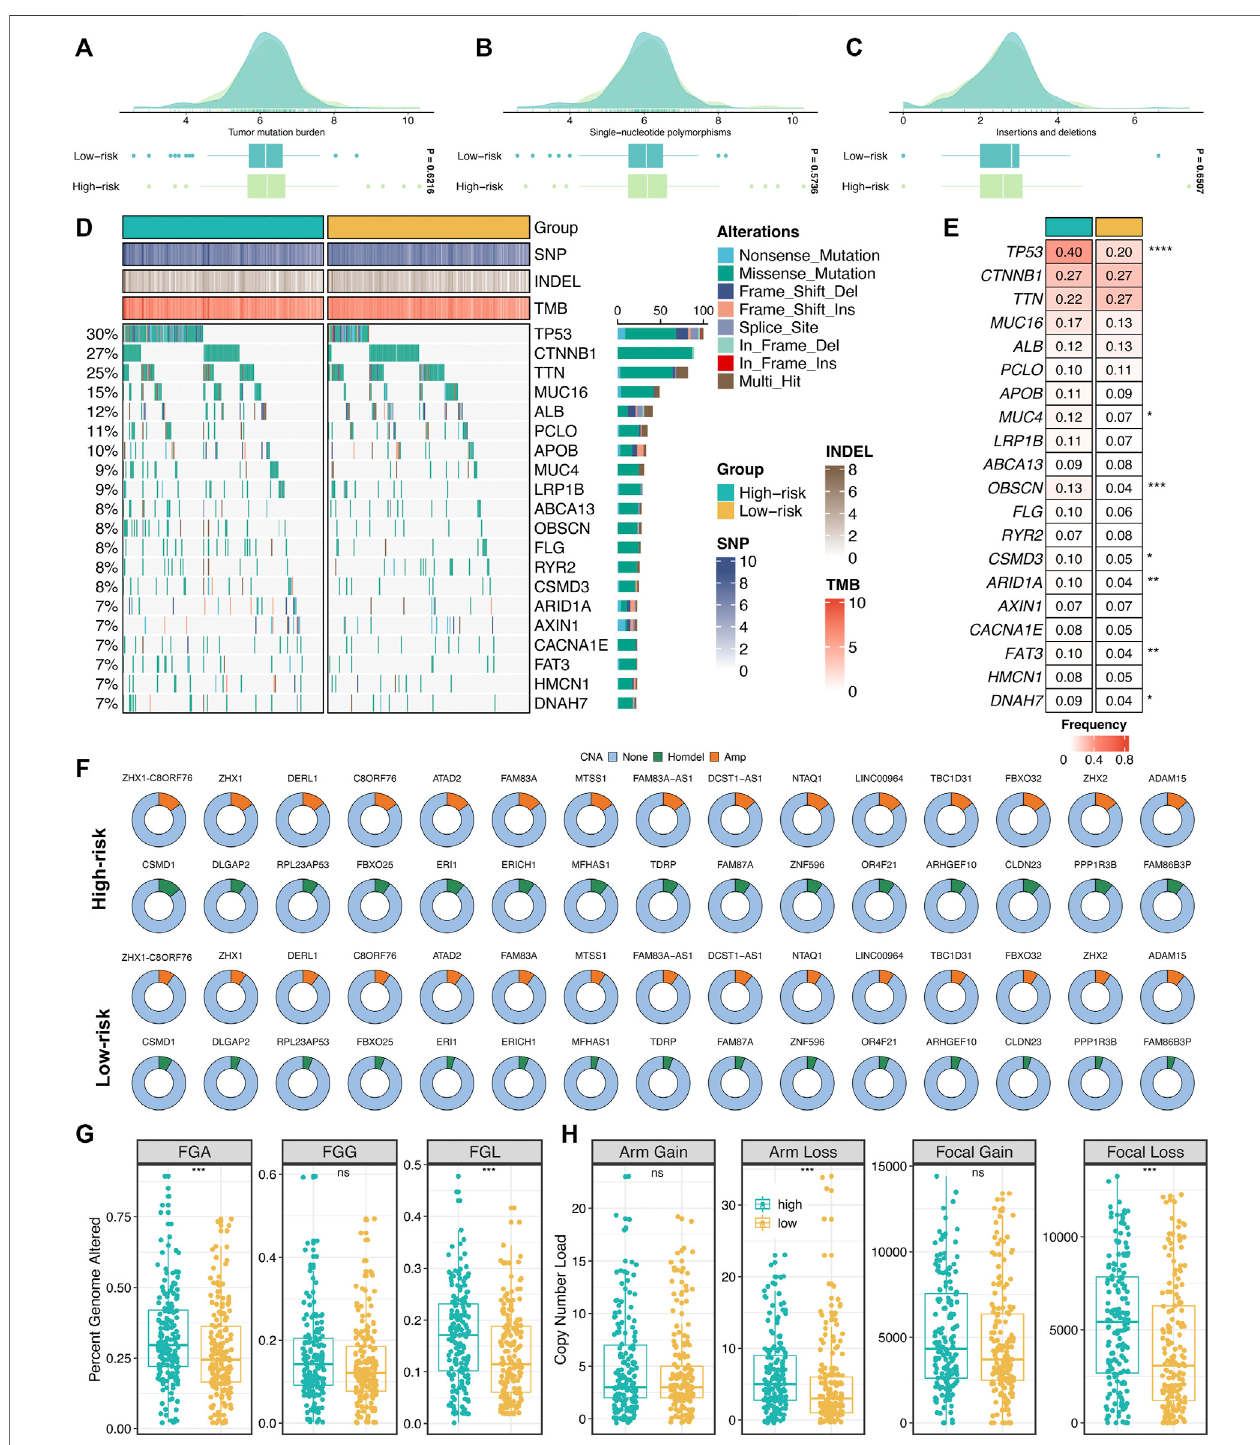
FIGURE9 | Genomic landscape of ProLncS. (A – C) Distributionsof TMB (A) , SNP (B) ,and Indel (C) between two risk groups. (D,E) Mutational landscape (D) and frequency (E) of the top 20 FMGs between two groups. (F) CNV frequency of 30 FAGs/FHGs between two groups. (G) Distributions of a fraction of genome alteration, gain and lost between two groups. (H) Distributions of arm gain, arm loss, focal gain, and focal loss. ns P < 0.05, * p < 0.05, ** p < 0.01, *** p < 0.001, **** p < 0.0001.